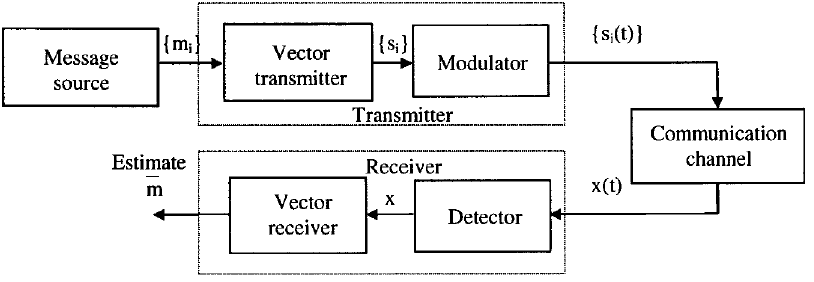
FIGURE 1 Model of band-pass data transmission